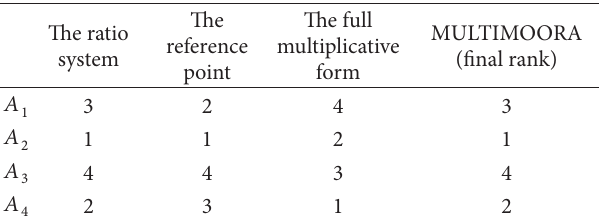
Table 9: Ranking of the alternatives according to